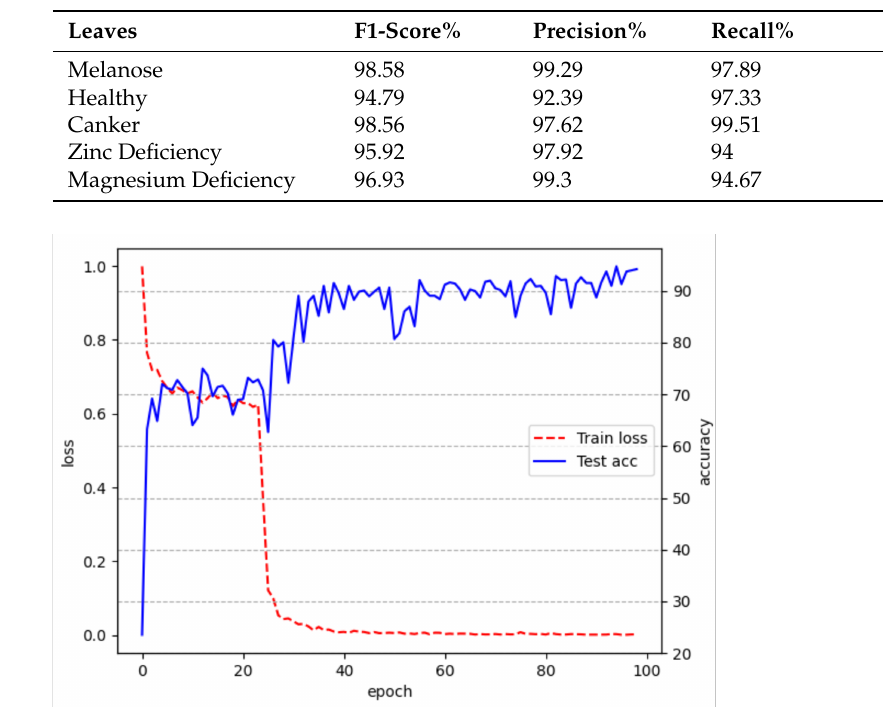
Table 4. EfficientNet-B5-pro classification result.